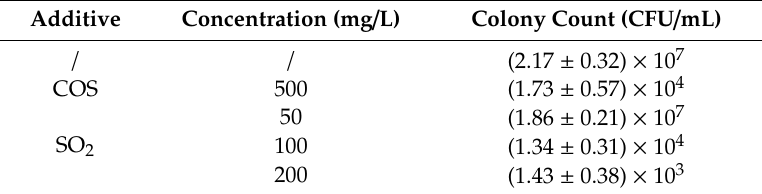
Table 2. Comparative analysis of antimicrobial e ff ects on the mixture of di ff erent wine spoilage organisms among using 500 mg / L COS and 50, 100, and 200 mg / L SO 2 as additives.